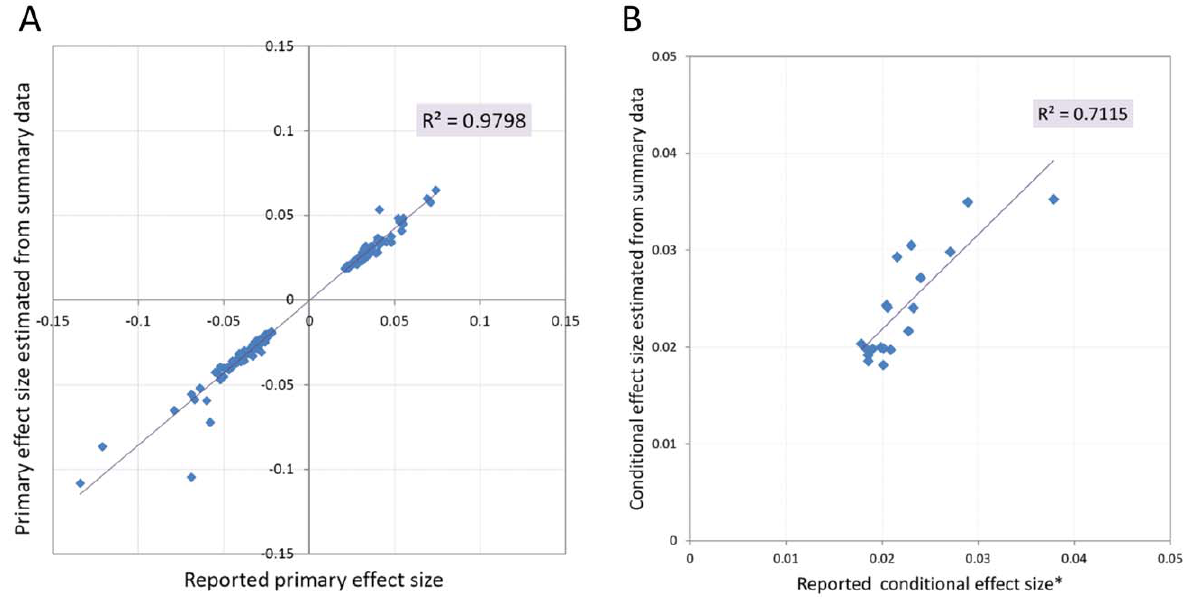
Figure 1. Correlation between reported and estimated effect sizes of the 180 primary height SNPs (A) and the 19 secondary SNPs (B) reported by Lango Allen et al. * The reference study did not report the effect sizes of the secondary signals. Here we used the values converted from the reported p-values based on conditional analyses in a subset of Stage 1 GIANT studies (Table 1 of Lango Allen et al).